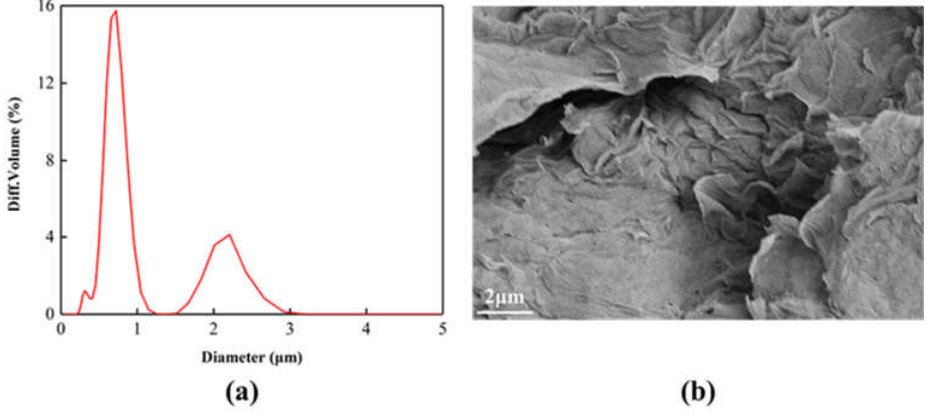
Figure 2. ( a ) Particle size distribution, ( b ) SEM images of the GO after sonication. The XRD patterns of the TiO 2 , TiO 2 /GO, TiO 2 /PANI, and TiO 2 /GO/PANI nanocom-